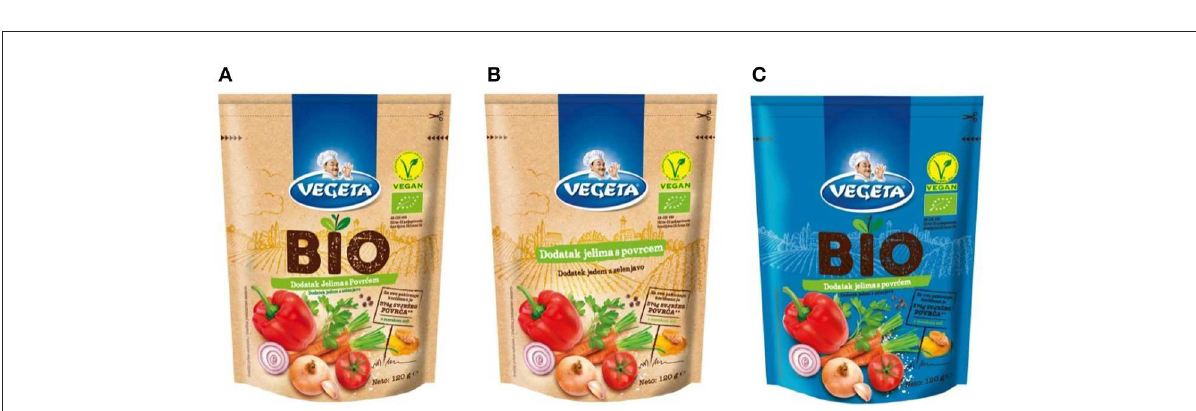
products were made by Podravka exclusively for the purposes of this